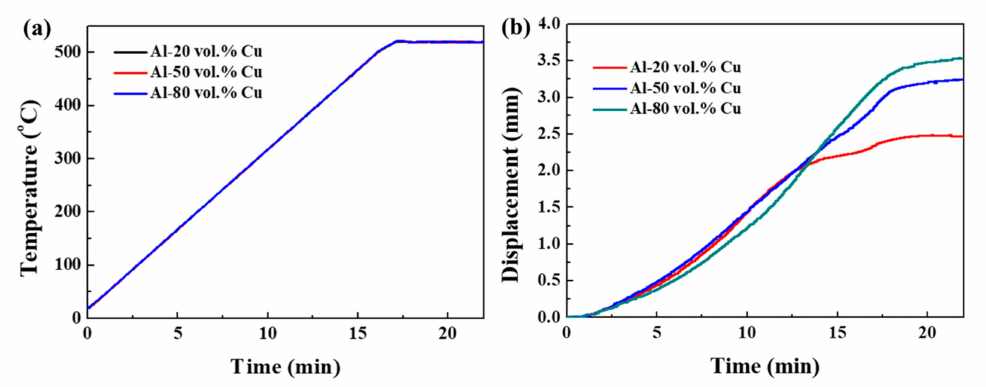
Figure 3. Variation of ( a ) the temperature and ( b ) displacement, as function of holding time